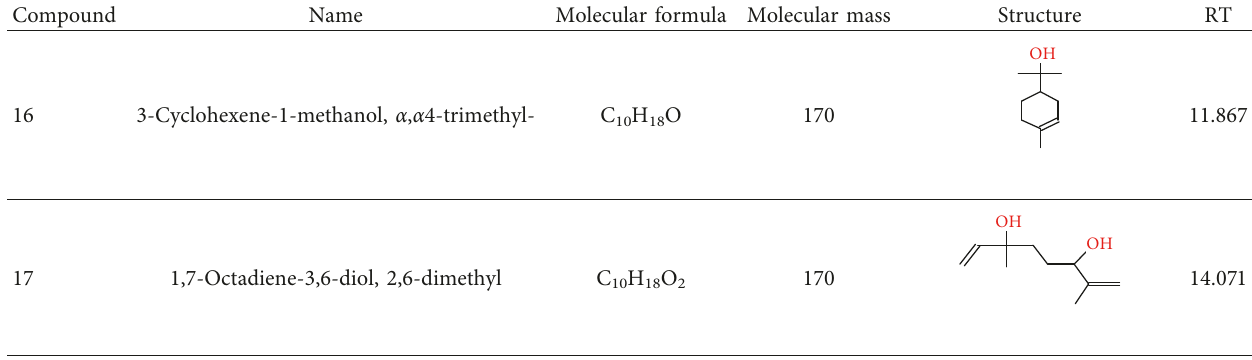
Table 5: Molecular formula, molecular mass, structure, and RTof compounds 16–20 of whole plant n -hexane fraction of Achillea wilhelmsii